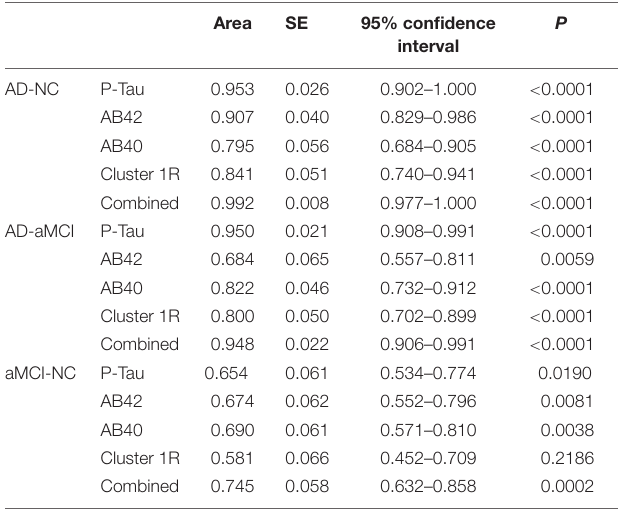
TABLE 6 | Receiver operating characteristic curve parameters of the AD-NC, AD-aMCI, and aMCI-NC